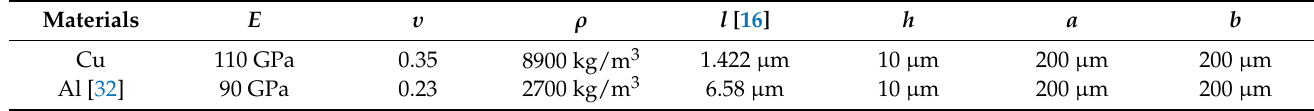
Table 1. Material properties of Cu and